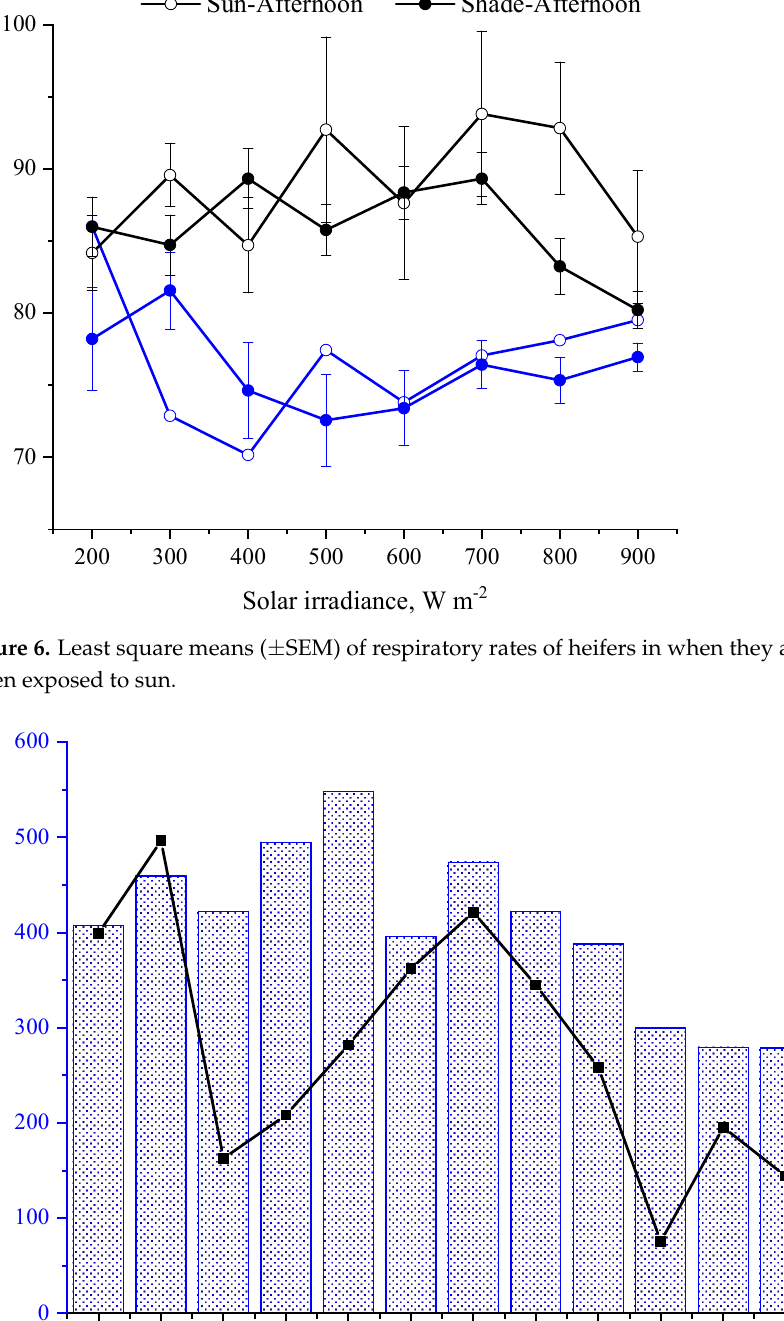
Figure 8. Least square means of enteric methane emission of heifers. This study demonstrated that use of shade from solar panels significantly reduced the heat load on heifers, reduced their body temperature and respiration rate, generated renewable electric energy and provided a source of income. The amount of CO 2 saved by